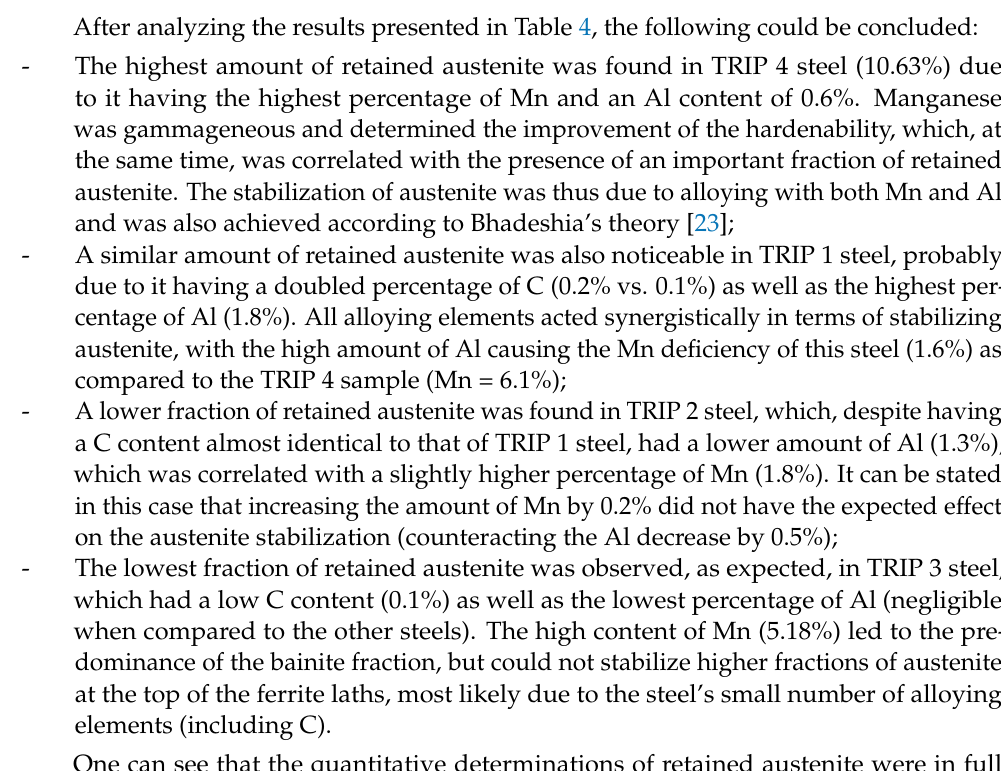
Figure 12. Austenite peaks (220) measured at three points for the TRIP 4 sample after impact bend- ing test. Table 5. Fractions of retained austenite in samples submitted to impact bending tests, V γ 2 . Sample Code